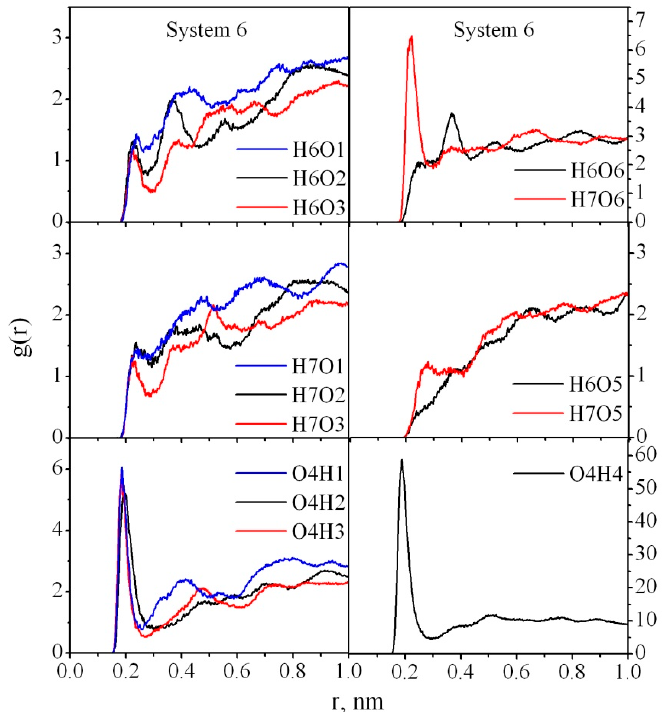
Figure 10. Atom–atom radial distribution functions for PAM–CNC in System 6.